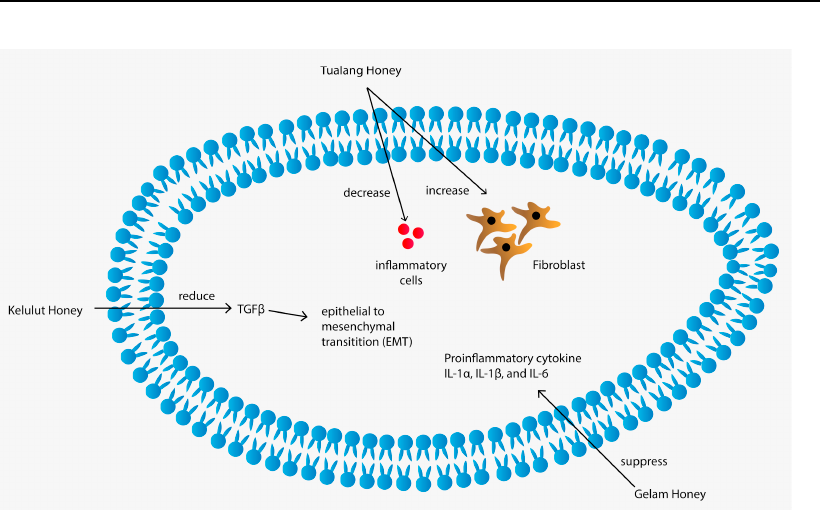
Figure 5. Wound-healing mechanism of Tualang, Gelam and Kelulut honeys. TGF β : transforming growth factor beta; IL-1 α : interleukin-1 α ; IL-1 β : interleukin-1 β ; IL-6: